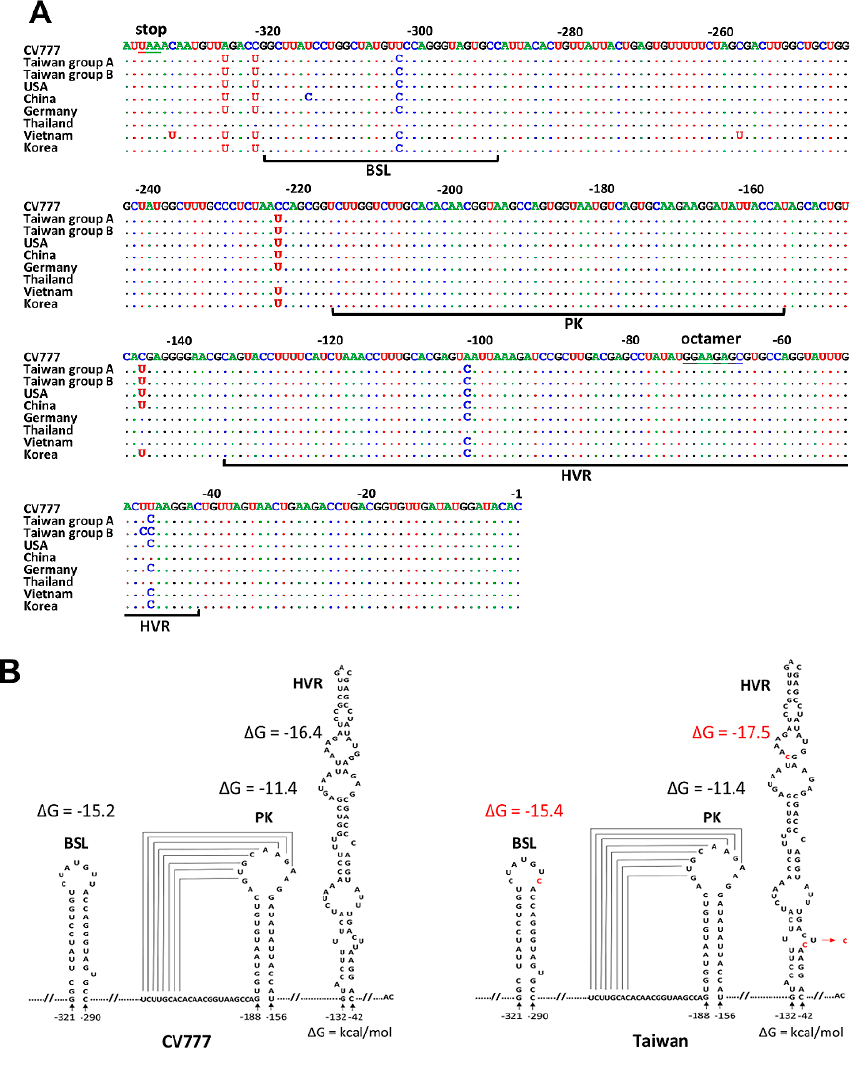
Figure 2. Sequence and structures of the PEDV 3 ′ UTR. ( A ) Nucleotide sequence alignment of the 3 ′ UTR between CV777, TW, and reference strains. The UAA stop codon for the N ORF and a highly conserved octarmeric element, GGAAGAGC, are underlined. The position numbers, counting from the poly(A) tail, refer to the composite sequence. Nucleotide identity between sequences is indicated with a dot; a difference is indicated with a new letter code. ( B ) Structure prediction of the 3 ′ UTR of CV777 and TW. Please refer to Figure 1 for the GenBank accession numbers of the reference strains. BSL, bulged stem-loop; PK, hair-pin pseudoknot; HVR, hypervariable region.